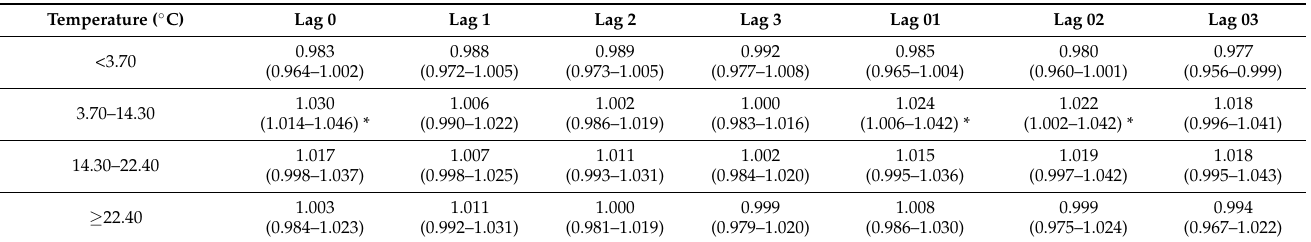
Figure 2. The nonlinear curve for the association between different temperatures and AMI. The black line is the log relative risk, and the gray area is the 95% confidence intervals of the risk estimates. Table 3. Adjusted relative risk for daily cases of AMI event (95% CI) per 10 µ g/m 3 increase in PM2.5 at different lag days, stratified by quartiles of daily mean temperature levels at lag 0 ab .